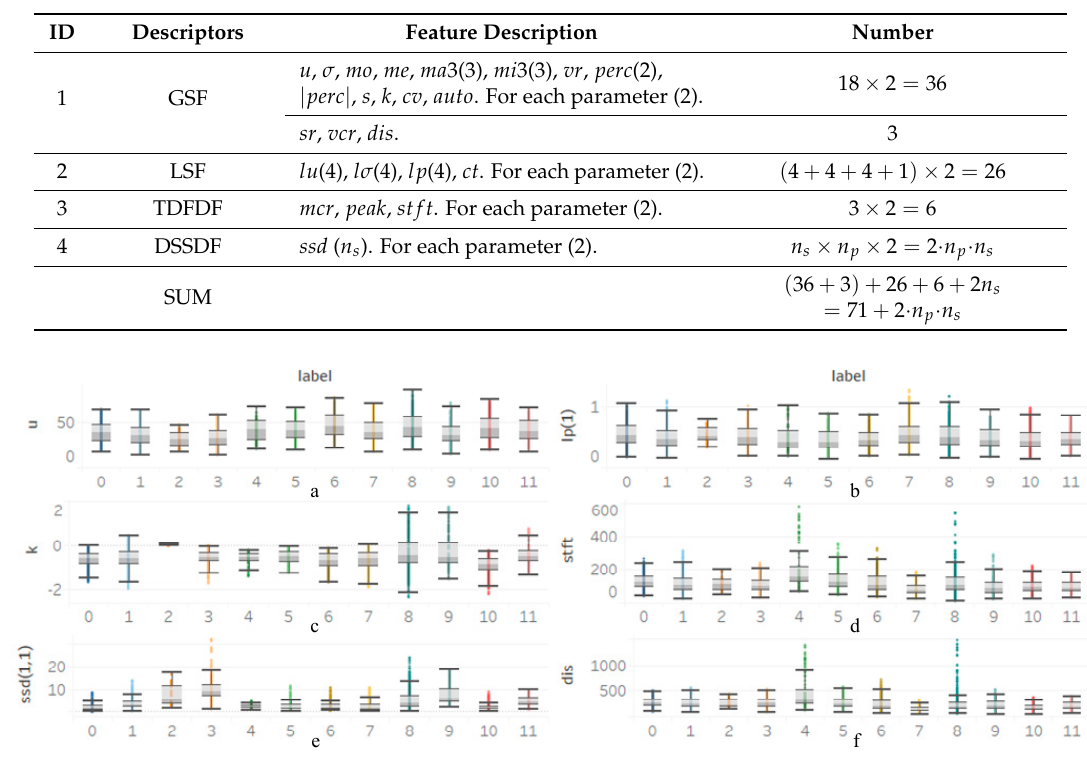
Figure 5. Distributions of some features: ( a ) u ; ( b ) lp ( 1 ) ; ( c ) k ; ( d ) stft ; ( e ) ssd ( 1,1 ) ; and ( f ) dis